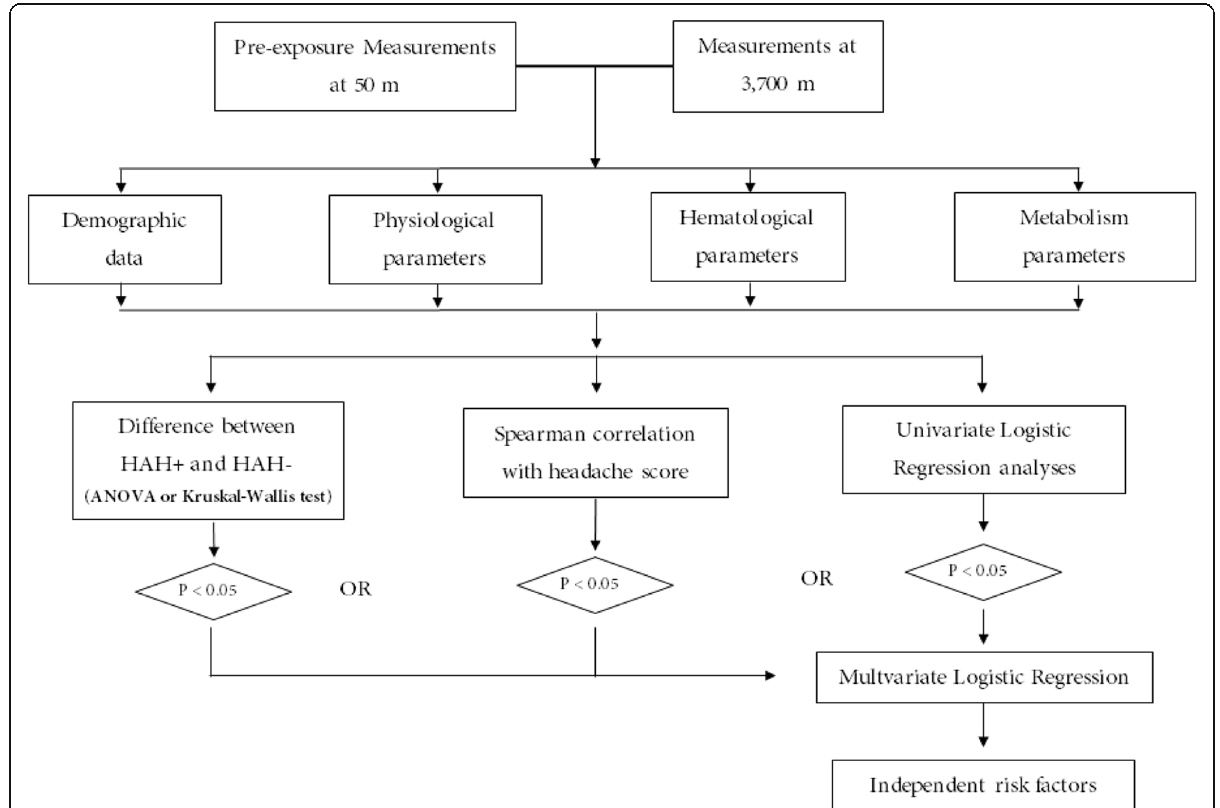
Fig. 1 The flowchart of this study. HAH+, high-altitude headache (HAH); HAH-,